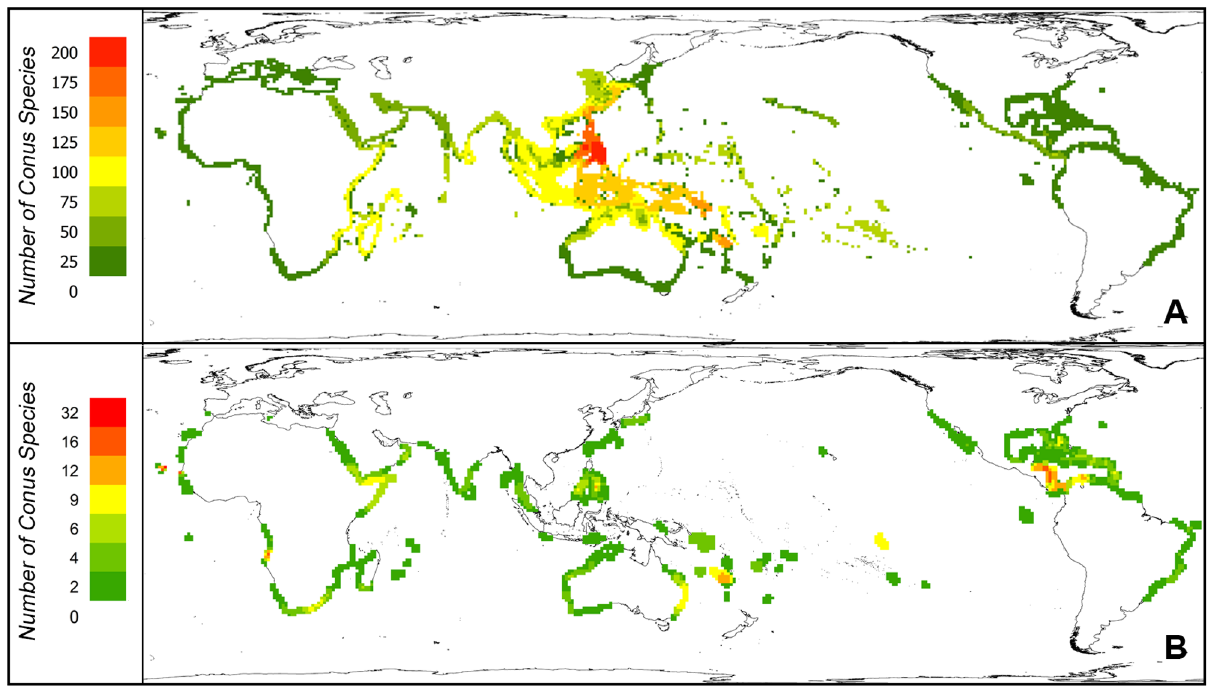
Figure 2. Conus species distribution. Species richness from a composite of individual species maps (Fig. 2A), and only species with mapped area less than the median indicating regions of potential endemism (Fig. 2B).